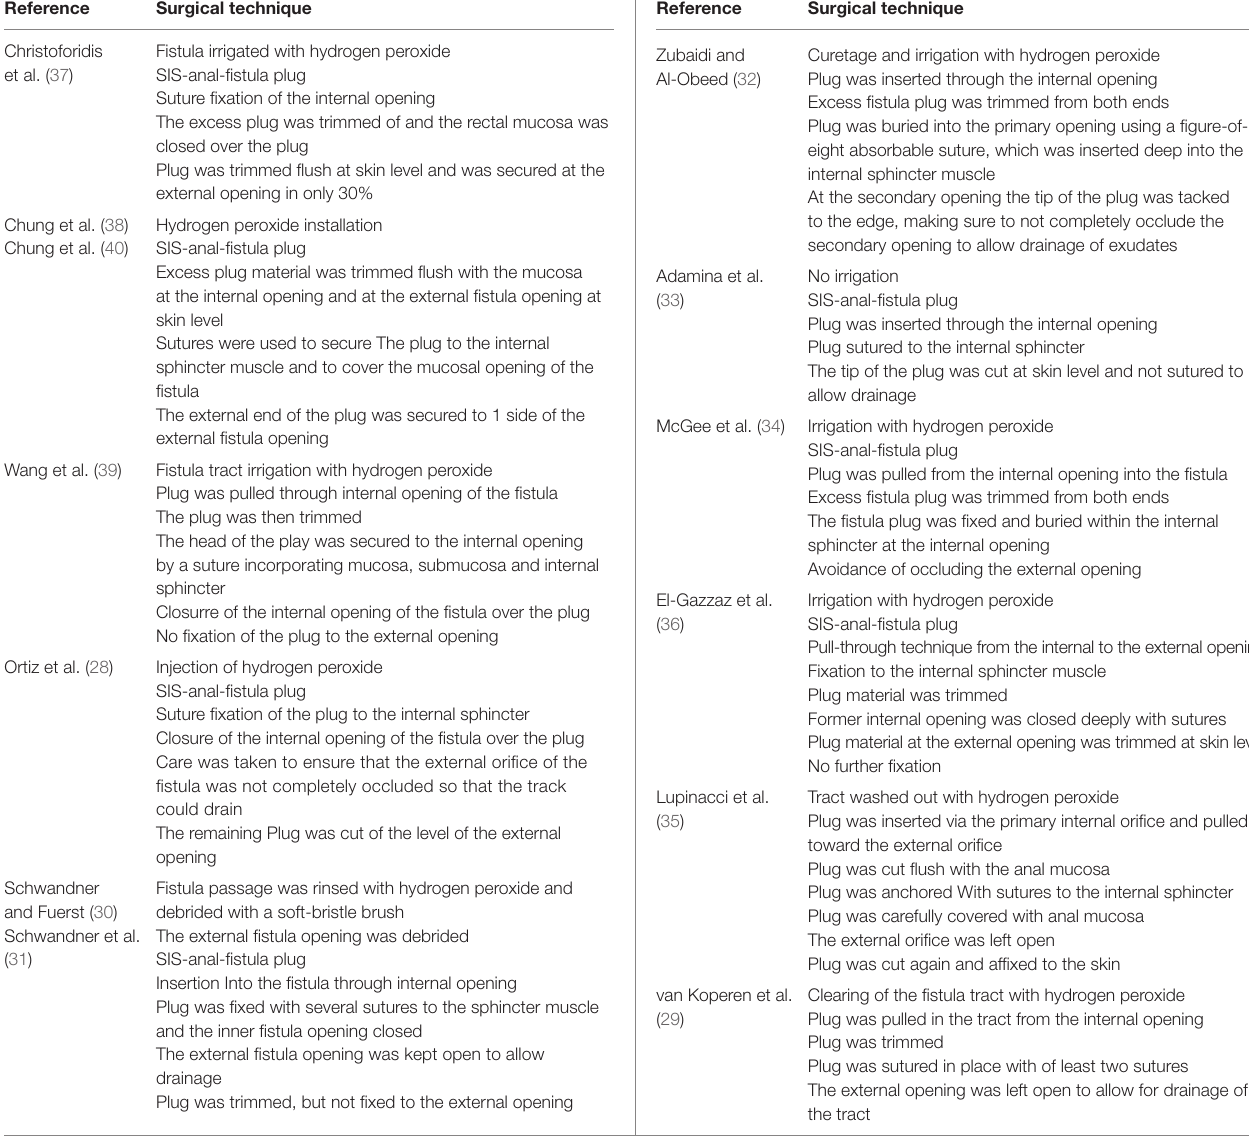
TABLe 3 | Surgical techniques used in the studies included in the systematic review of O’Riordan et al. (3) minus abstracts and studies already analyzed in the review of Garg et al. (13).